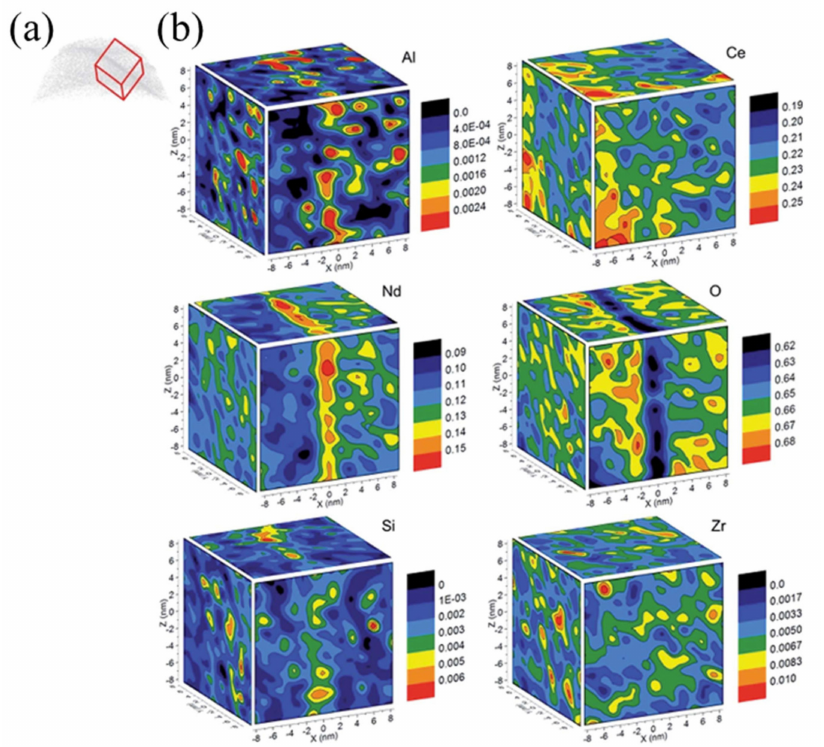
Figure 5. ( a ) Atom probe data reconstruction for Nd 0.30 Ce 0.70 O 2 (NCD30) showing Nd ions and a 3-D region of interest around the GB extracted for further analysis. ( b ) 2-D projections of the concentration of each species in at% from the depicted region of interest. The GB is especially apparent in the Figure 6. ( a ) concentration of Mg and Ca (at%) as a function of distance (nm) from the GB [70], ( b ) Electrochemical strain Figure 6. ( a ) concentration of Mg and Ca (at%) as a function of distance (nm) from the GB [70], ( b ) Electrochemical strain O deficiency and Nd enhancement. There is also evidence of Al and Si enrichment at the GB [79]. microscopy (EMS) detecting space charge in a polycrystalline Sm-doped ceria. ESM map of response magnitude for ±3V microscopy (EMS) detecting space charge in a polycrystalline Sm-doped ceria. ESM map of response magnitude for ±3V Reproduced from [79] with permission from The Royal Society of Chemistry. perturbation, revealing increased response in the GB [71]. Figure 6a reprinted from Journal of the American Ceramic So- perturbation, revealing increased response in the GB [71]. Figure 6a reprinted from Journal of the American Ceramic So- ciety, 57, Taylor, R.I., Coad, J.P. and Brook, R.J., Grain Boundary Segregation in Al 2 O 3 , 539–540, Copyright (2006), with ciety, 57, Taylor, R.I., Coad, J.P. and Brook, R.J., Grain Boundary Segregation in Al 2 O 3 , 539–540, Copyright (2006), with permission from John Wiley and Sons. Figure 6b reprinted from Progress in Materials Science, 89, Giuliano Gregori, Ro- permission from John Wiley and Sons. Figure 6b reprinted from Progress in Materials Science, 89, Giuliano Gregori, Ro- traut Merkle, Joachim Maier, Ion conduction and redistribution at grain boundaries in oxide systems, 252–305, Copyright traut Merkle, Joachim Maier, Ion conduction and redistribution at grain boundaries in oxide systems, 252–305, Copyright (2017), with permission from Elsevier. (2017), with permission from